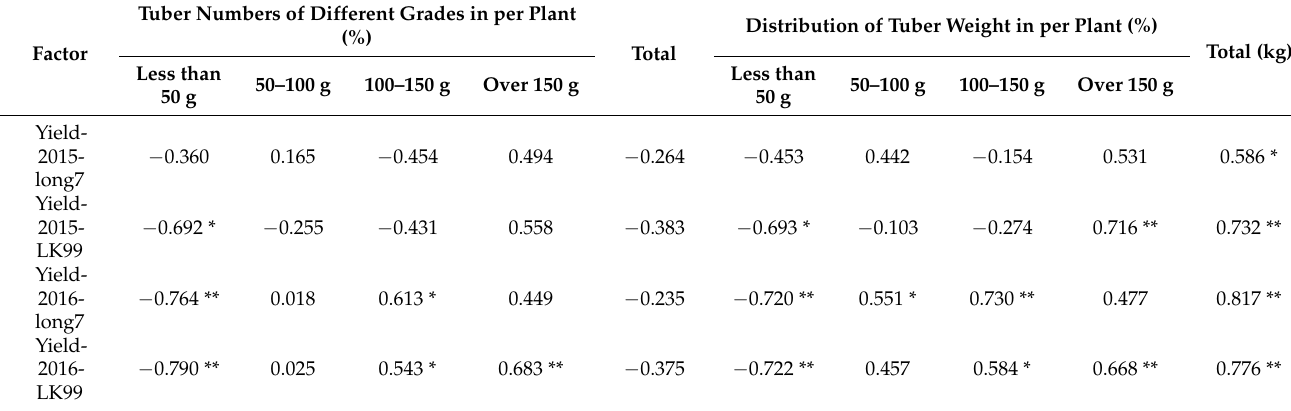
Table 6. Correlation Analysis between Yield and Yield